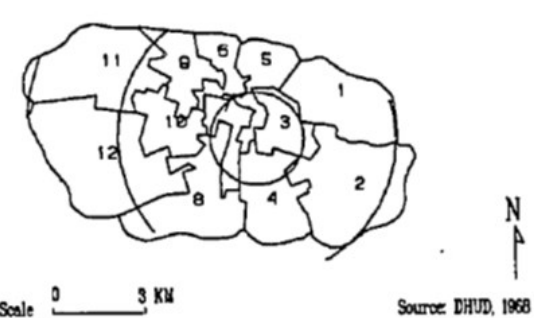
Figure 4. Zone Boundaries in Tabriz (in 1966) (Azimi, 1995, p. 64).